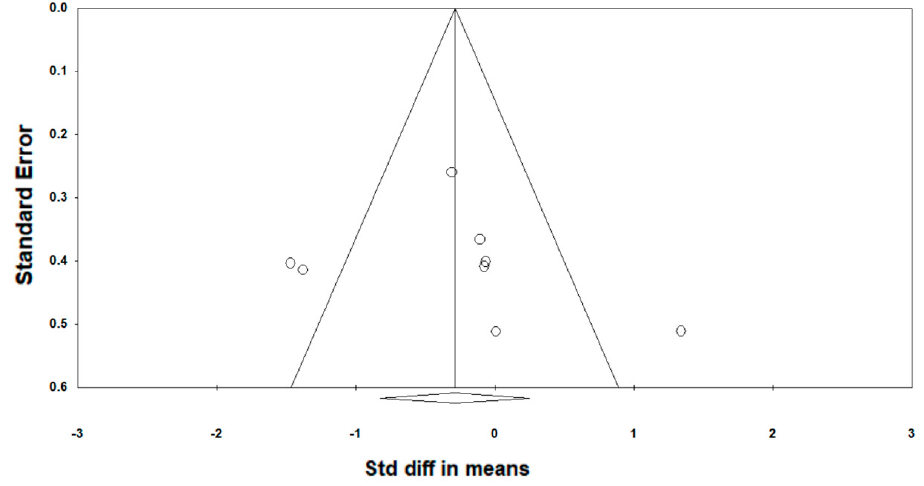
Figure 2. Funnel plot analysis. Circles represent the data from eight individual studies.